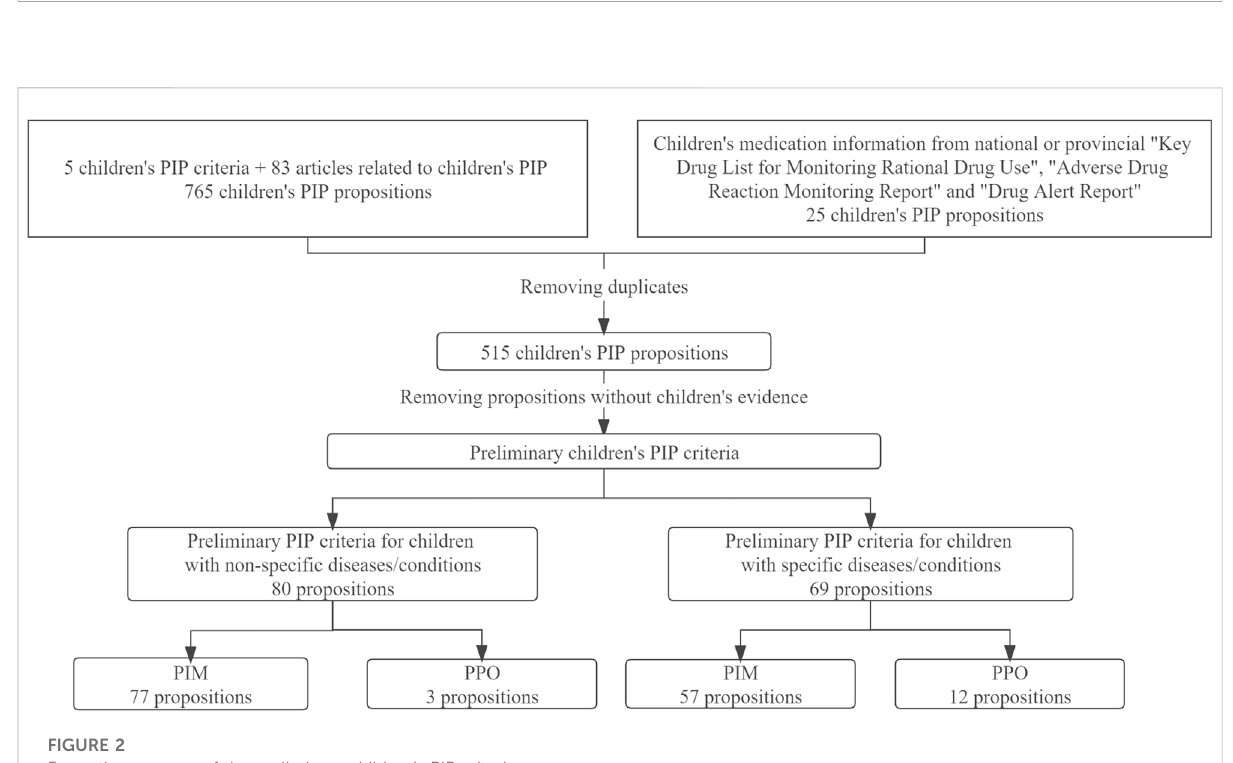
FIGURE 1 Delphi survey process.